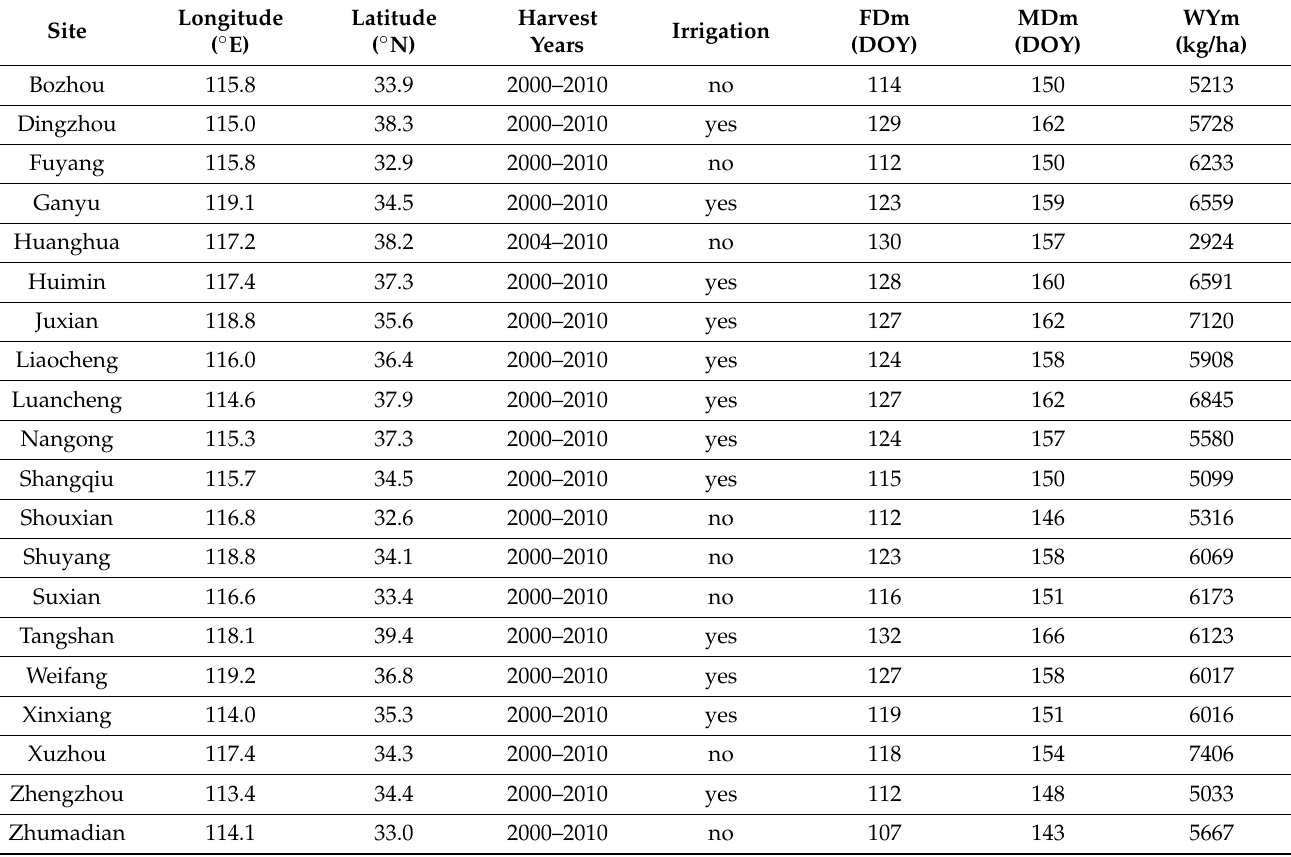
Table 1. Related information about the 20 investigated sites in the